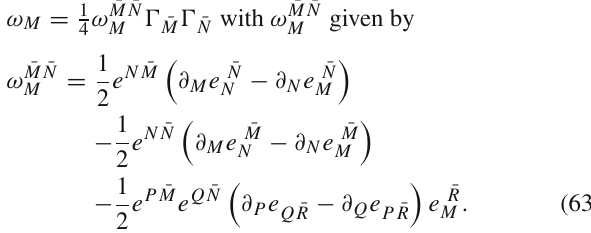
where ω M is the spin connection defined as